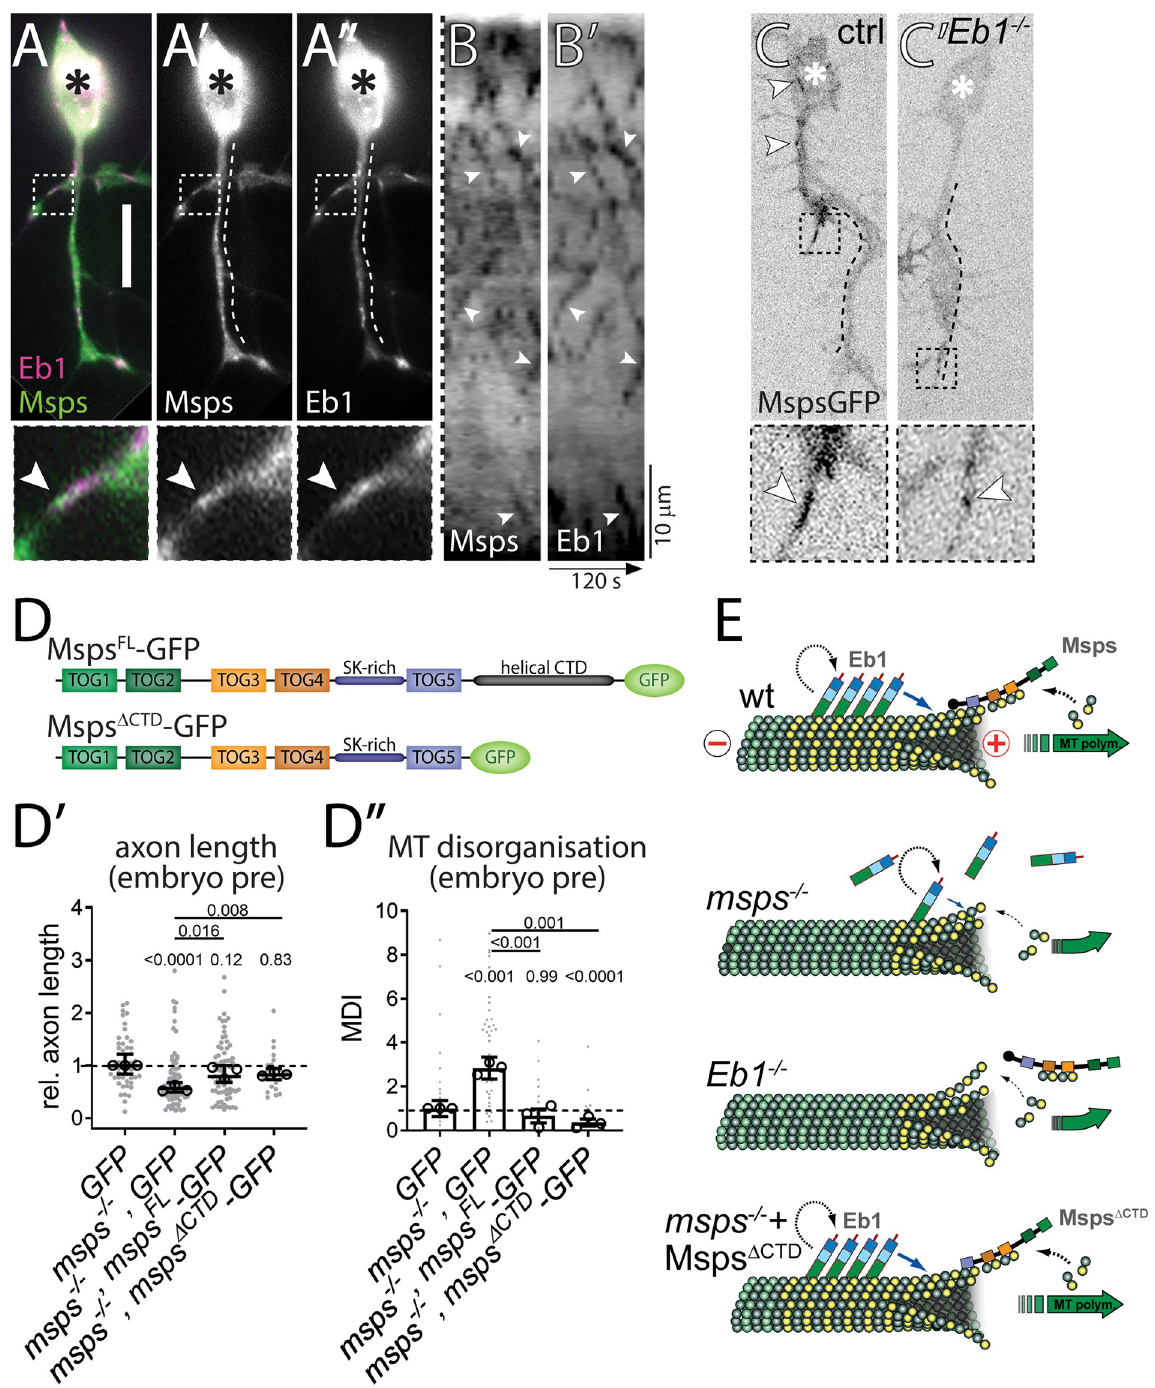
Fig 4. Eb1 and Msps depend on each other for MT plus-end localisation. A-A” ) Primary neurons at 6HIV co-expressing Eb1::mCherry (magenta, Eb1) and Msps FL ::GFP (green, Msps) and imaged live; asterisks indicate somata, scale bar represents 10 μ m, dashed boxes indicate the positions of the 3.5-fold magnified close-ups shown at the bottom with arrowheads pointing at the position of Msps::GFP accumulation (same in C,C’). B,B’ ) Kymograph of live movies (as in A-A”) with the dashed line on the left representing a straightened version of the dashed lines shown in A’ and A” (i.e. the length of the axon; proximal at the top) and the x-axis indicating time; arrowheads point at trajectories of Msps and Eb1 which are almost identical. C ) Primary neurons expressing Msps::GFP and imaged live, either displaying wild-type background (ctrl) or being homozygous mutant for Eb1 04524 ( Eb1 -/- ); white arrowheads point at Msps::GFP comets which are much smaller in the mutant neurons. D ) Schematic representations of Msps FL ::GFP and Msps Δ CTD ::GFP. D’,D” ) Graphs displaying axon length and MT curling (as indicated) for pre-cultured embryonic primary neurons expressing GFP or Msps::GFP constructs via the elav-Gal4 driver, either in wild-type or msps A/1